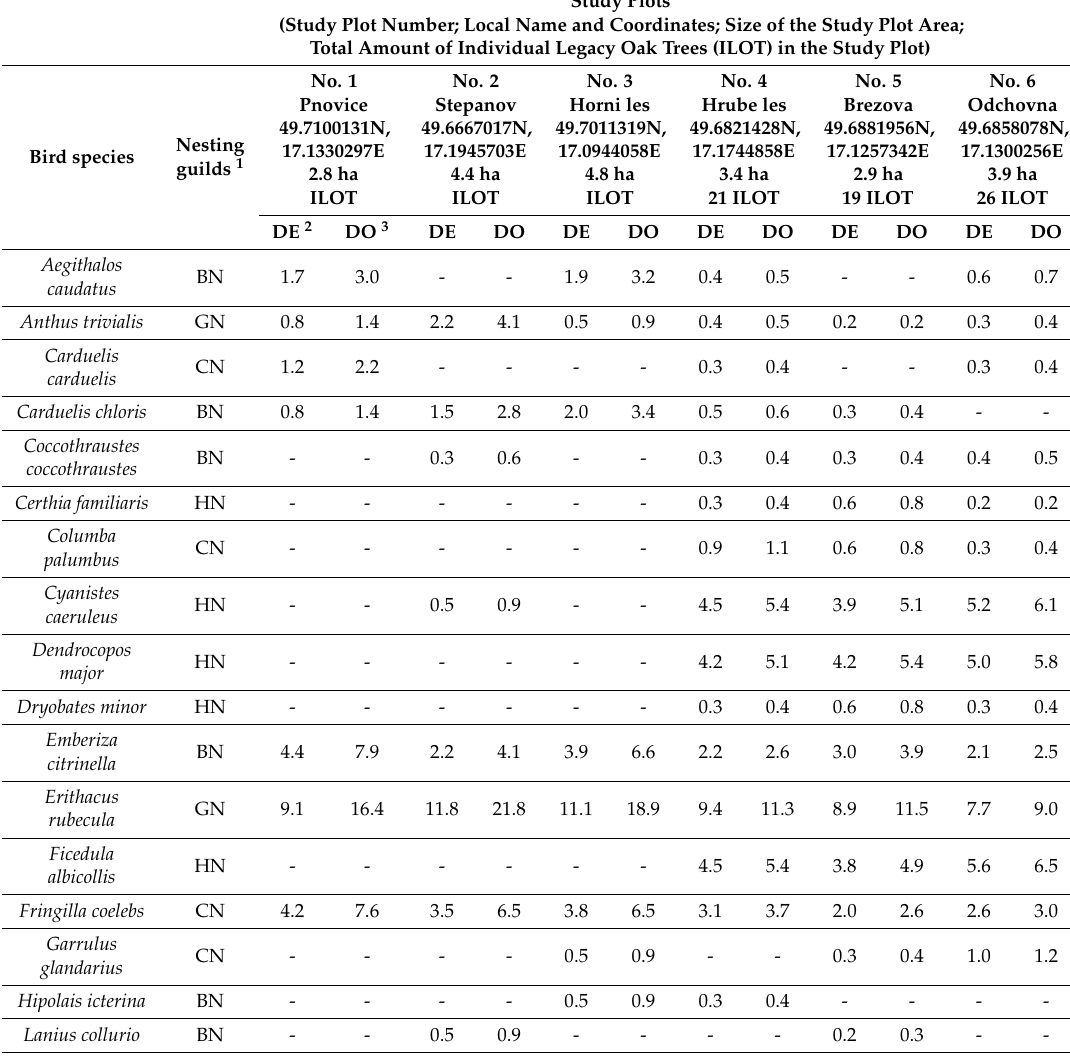
Table 1. Bird density and dominance in study plots. Study Plots (Study Plot Number; Local Name and Coordinates; Size of the Study Plot